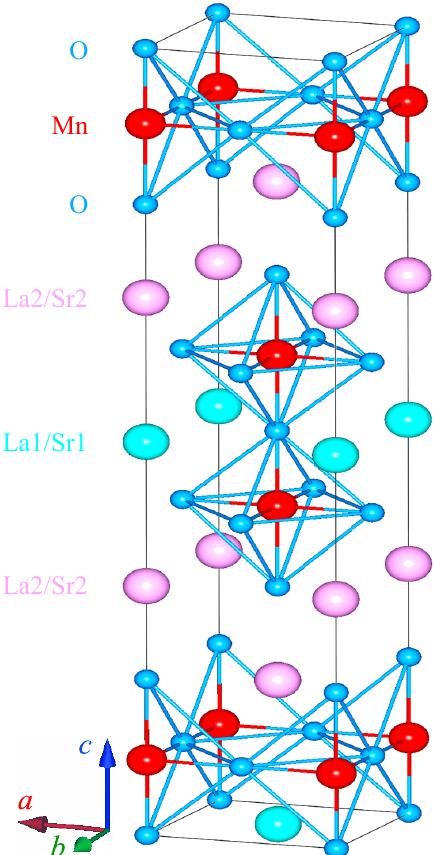
Figure 1. (color online) Tetragonal crystal structure of a La 1.37 Sr 1.63 Mn 2 O 7 single crystal in one unit cell (solid lines) with space group I 4/ mmm (No. 139). The La, Sr, Mn, and O ions are labeled, and the La and Sr ions are illustrated with the same color code. In this structure, there are two crystallographic sites for La1/Sr1 and La2/Sr2 ions and three sites for O ions (marked with the same color